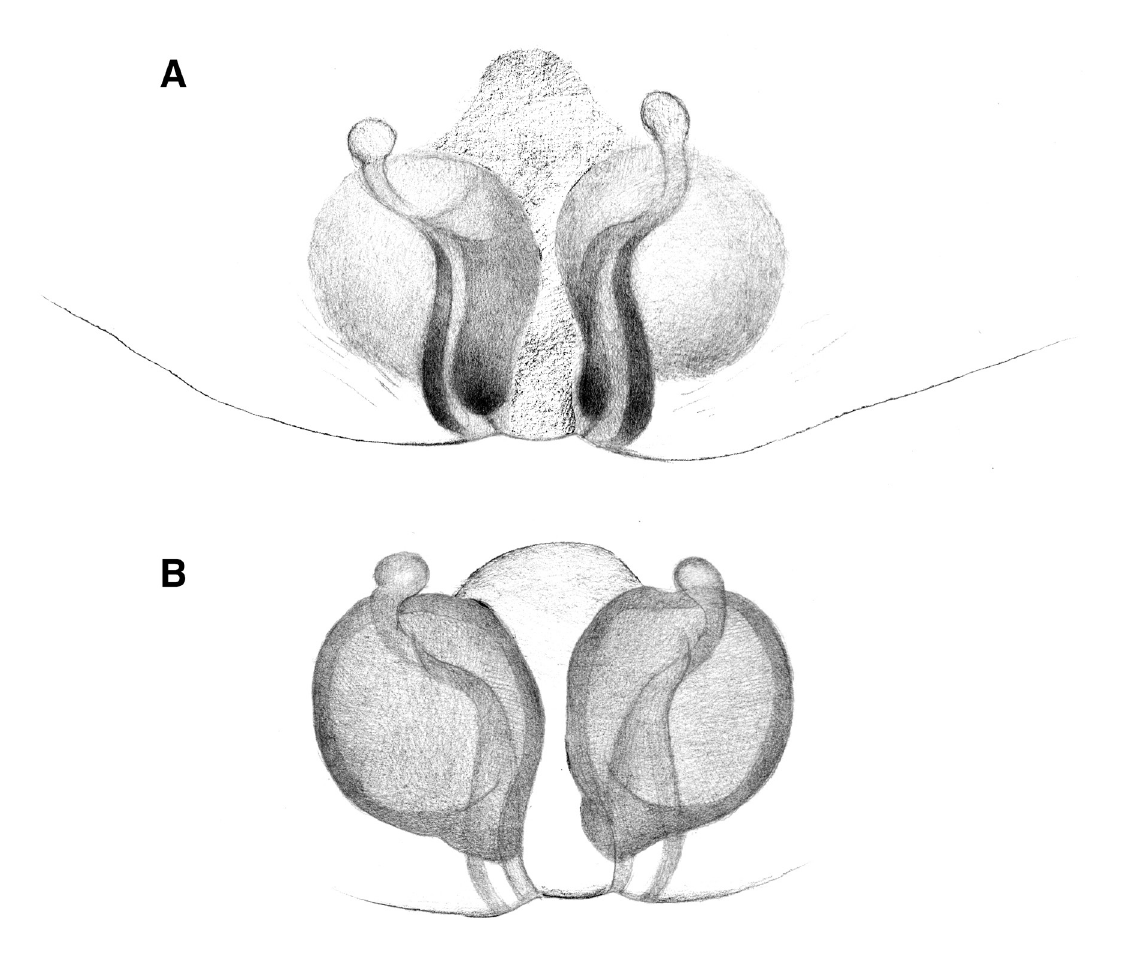
Fig. 7. Apollophanes fitzroyi sp. nov. A. ♀, epigyne (ventral view). B. Spermathecae (dorsal